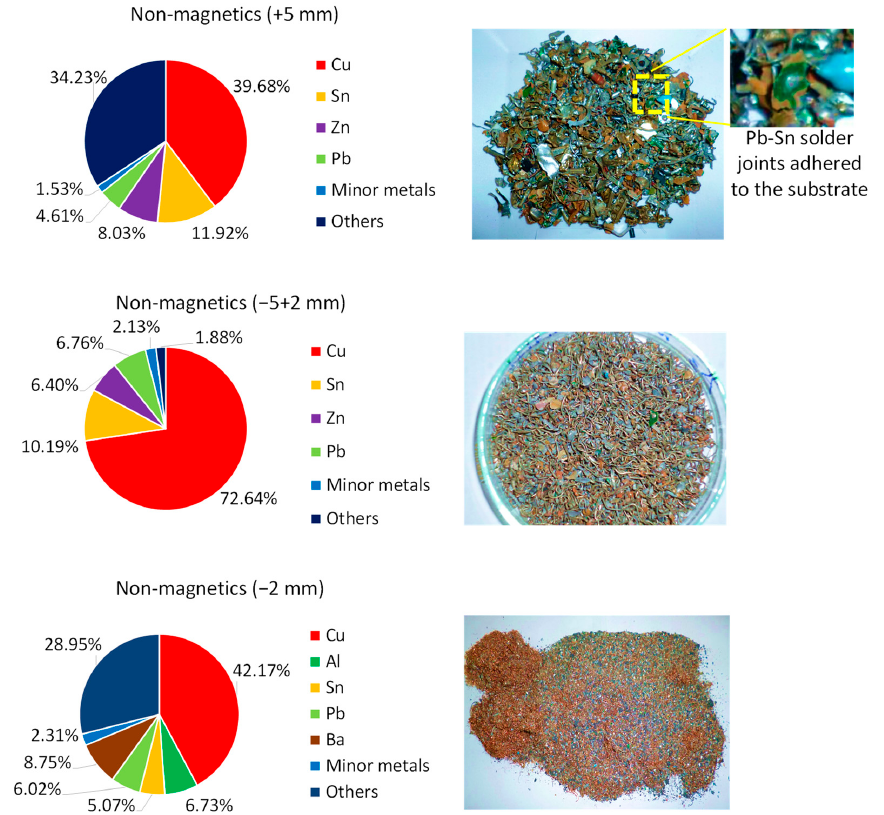
Figure 9. Elemental composition and pictures of the non-magnetic portion separated in the +2.8 g/cm³ fraction. “Minor metals” consider the sum of the elements Cu, Al, Fe, Sn, Zn, Pb, Ba, Mn, and Ni when not individually displayed. “Others” consider the sum of non-metallic elements and trace metals.